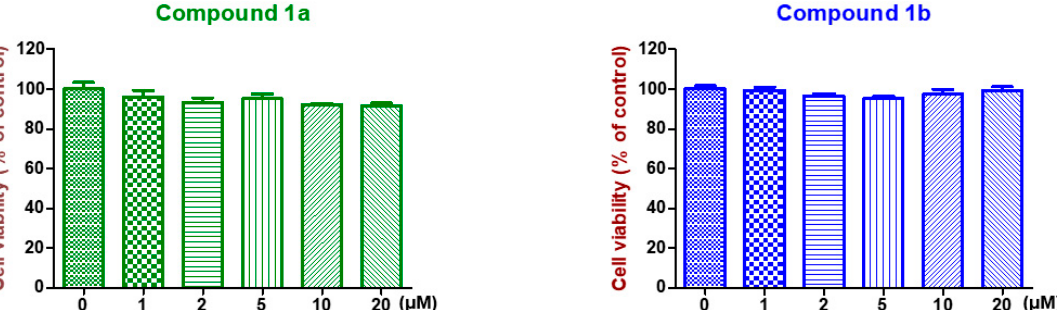
Figure 7. Effects of compounds 1a and 1b on B16F10 cell viability. Cell cytotoxicities were assessed using the EZ-Cytox assay after treating cells with 1a or 1b at 0, 1, 2, 5, 10, or 20 µ M for 48 h. Results are expressed as percentages of untreated controls, and bars represent standard errors. Experiments were conducted independently three times.